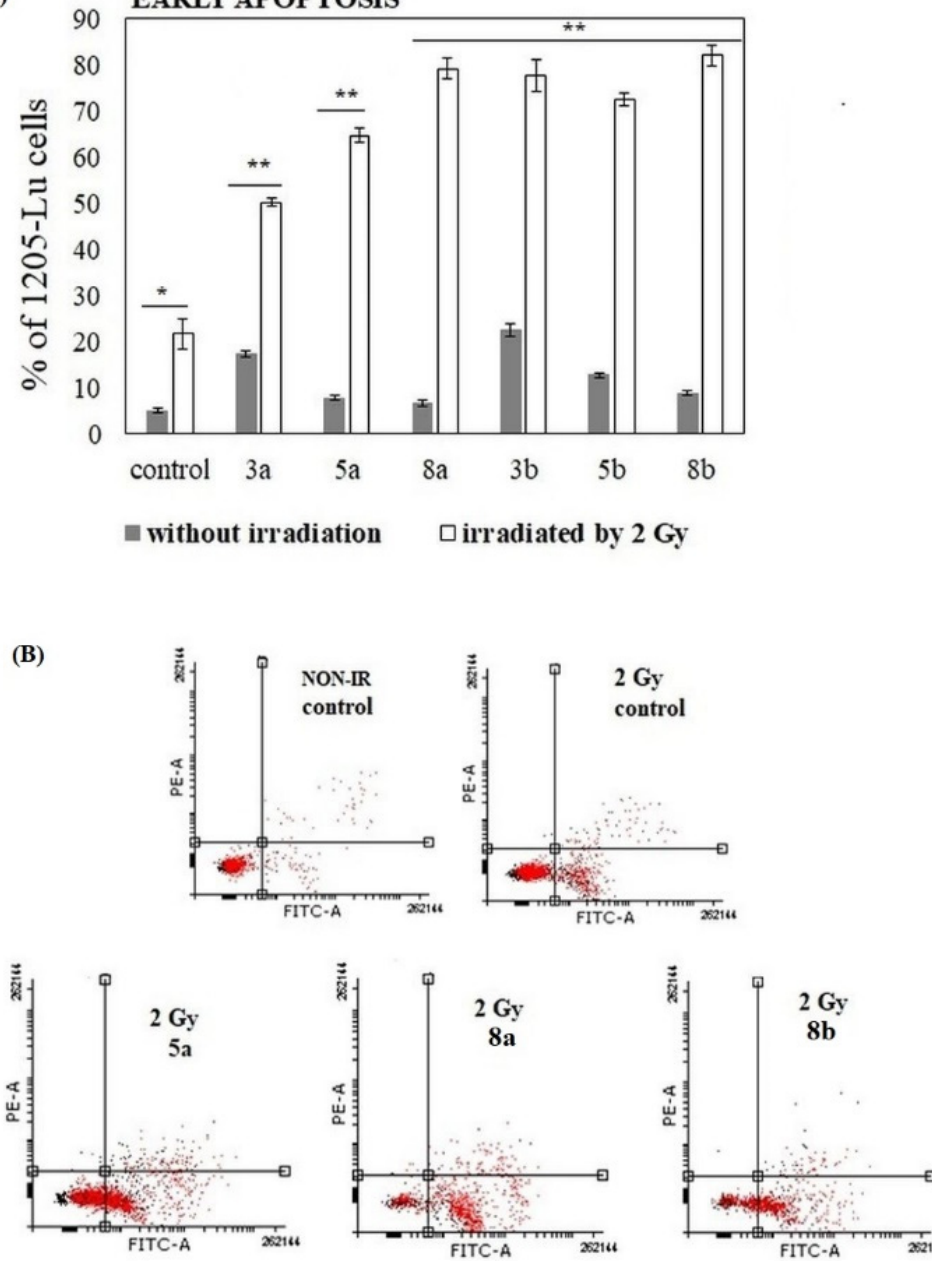
Figure 9. Pro-apoptotic effects of phenolic acid–PC conjugates in combination with ionizing in 1205-Lu cells. The percentages of early apoptotic cells pre-incubated with 100 µ M of the compounds (grey bars) were compared to the cells that were also irradiated (2 Gy) (white bars). The statistical significance was determined (* p < 0.05 and ** p < 0.001) ( A ). Representative histograms of events defined after forward and side scatters as cells (red dots) and debris (black dots) are shown ( B